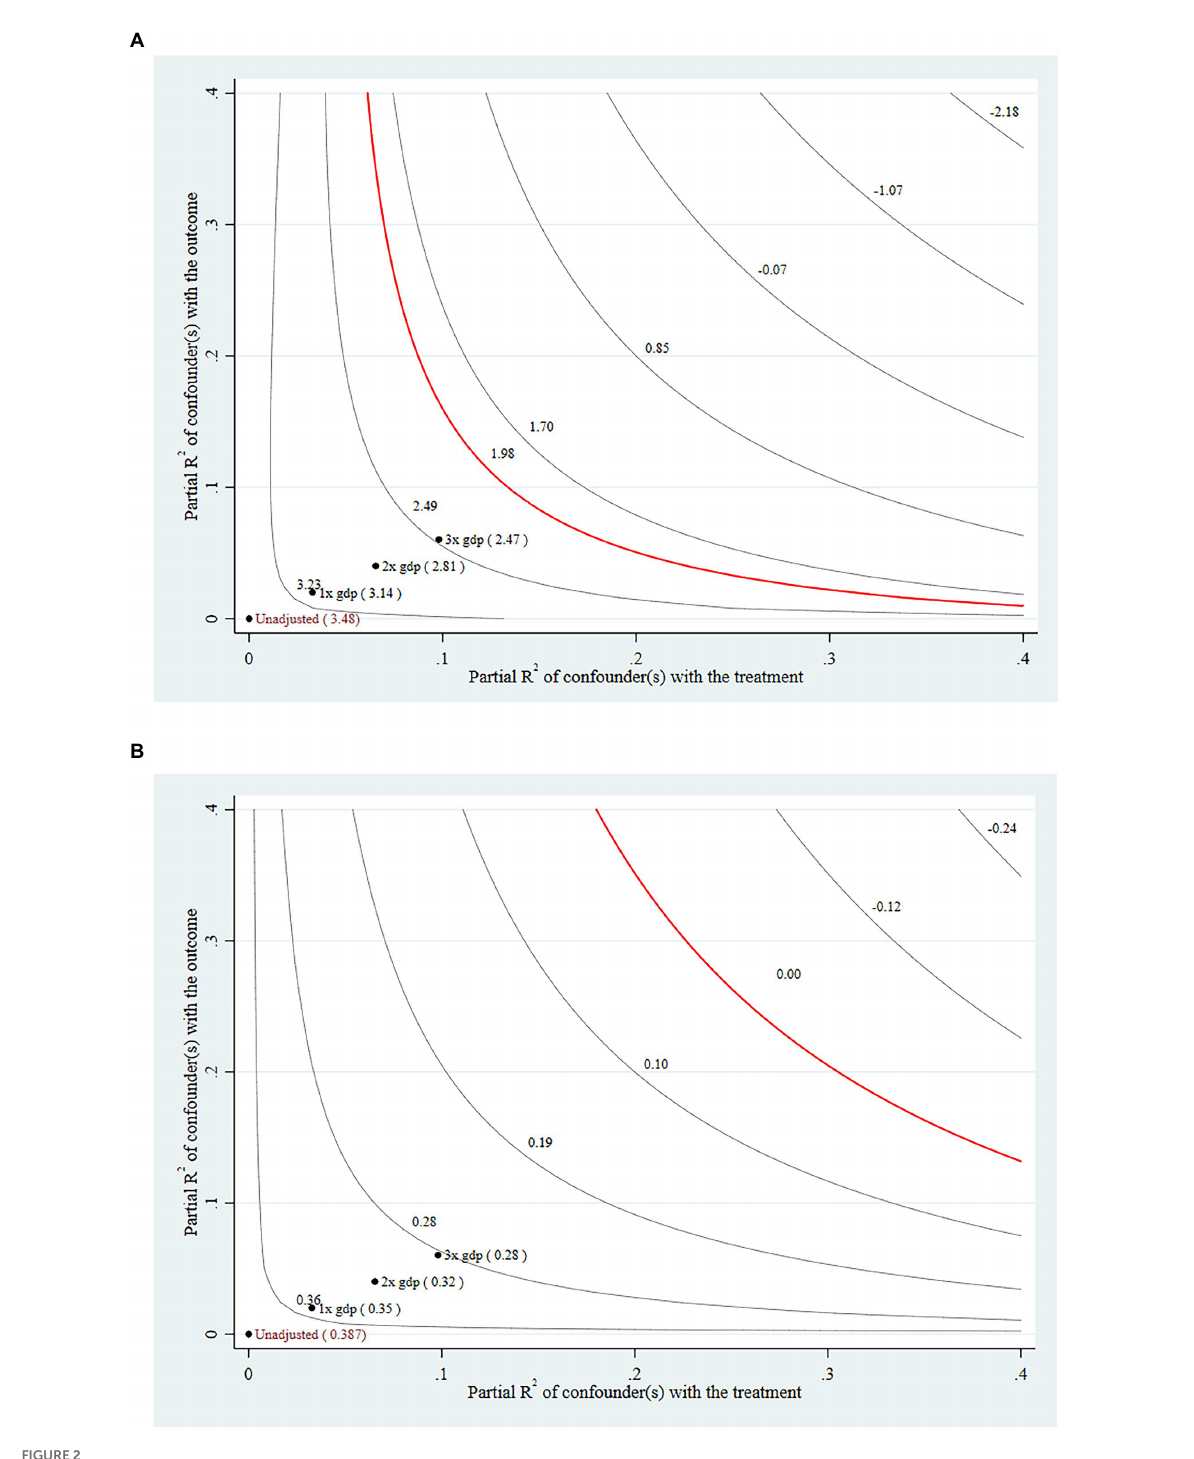
FIGURE 2 (A) The red line indicates the threshold at which the significance of the coefficients can be overridden, and when we successively add omitted variables with explanatory power, the threshold is not breached. The fact that the coefficients are significant in the baseline model is robust. (B) The red line indicates the threshold at which a positive coefficient can be overturned, and when we successively add omitted variables with explanatory power, the threshold is not breached. The fact that the coefficients are positive in the baseline model is